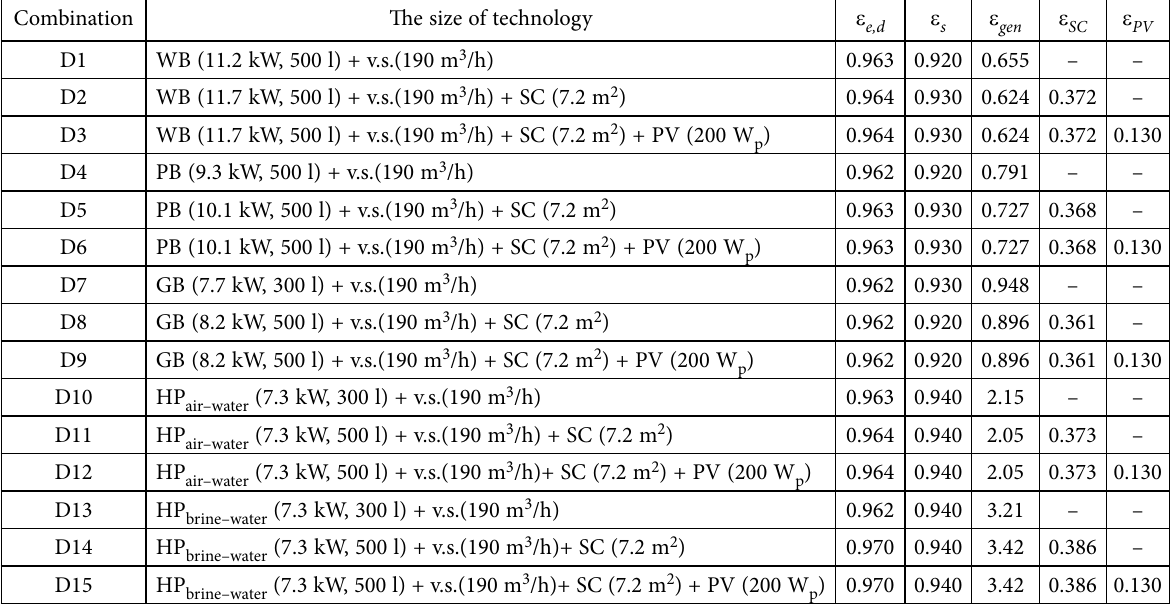
Table 4. Seasonal energy efficiency coefficients of generation, storage, distribution and emission subsystems of BESS of